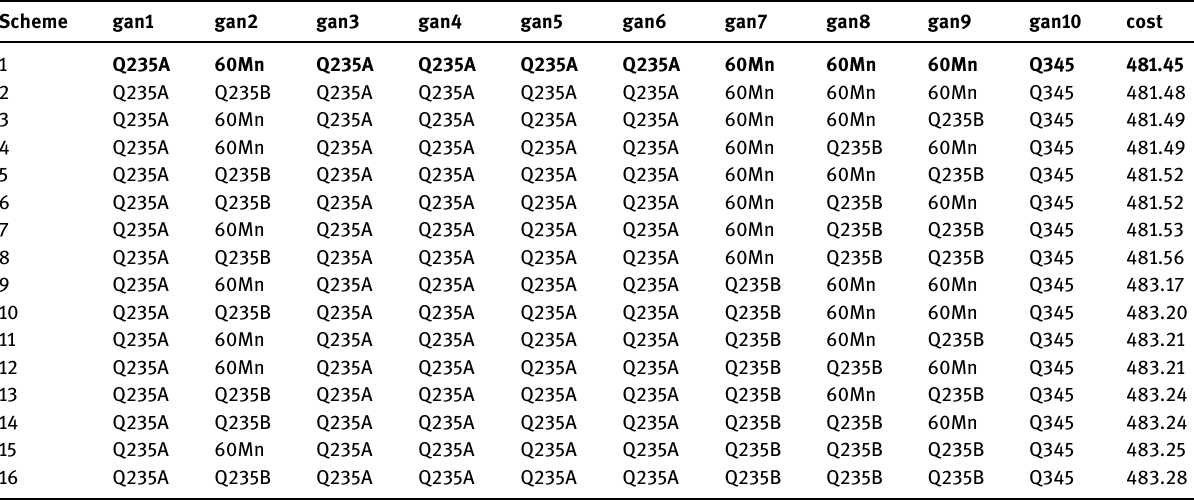
Table 8: Cost optimization schemes